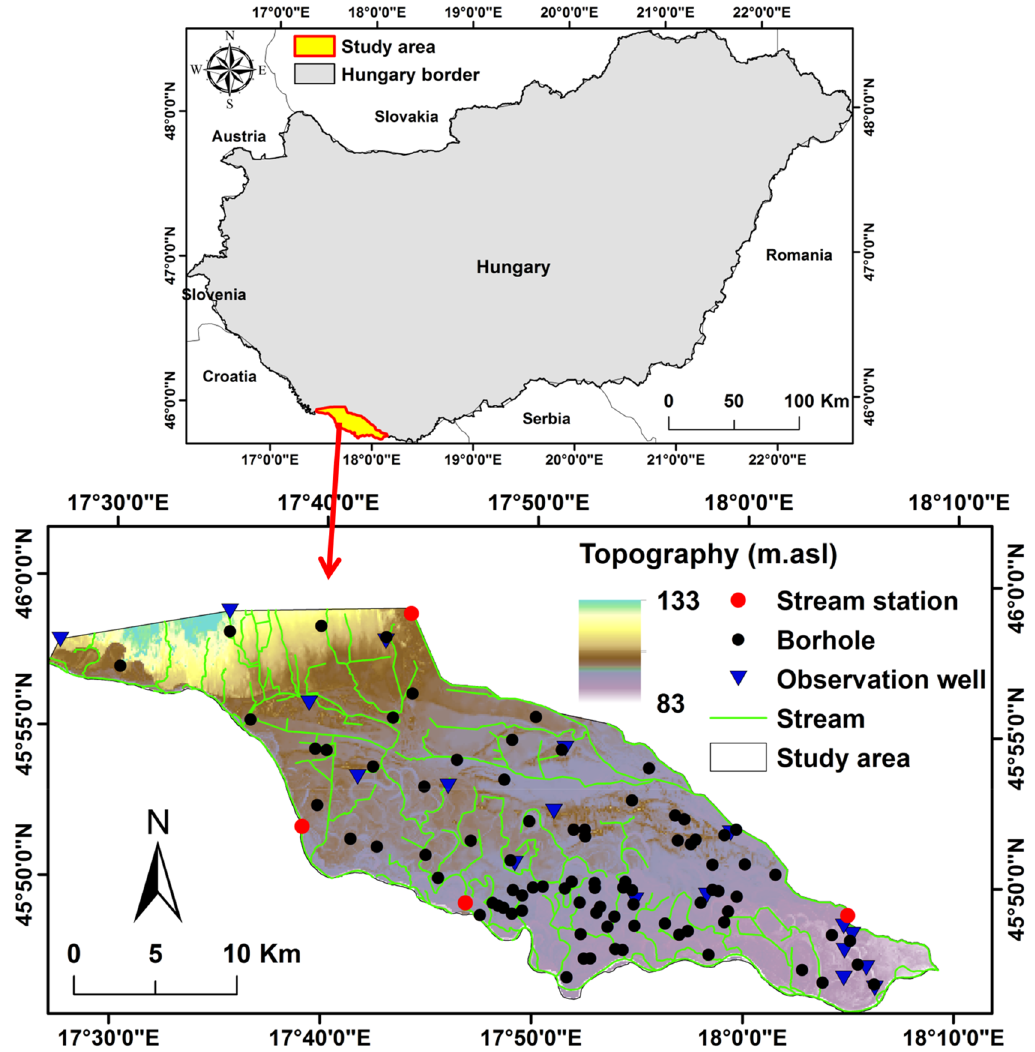
Figure 1. Location of the study area in Hungary, topography, streams, river gauges, boreholes and groundwater observation wells.